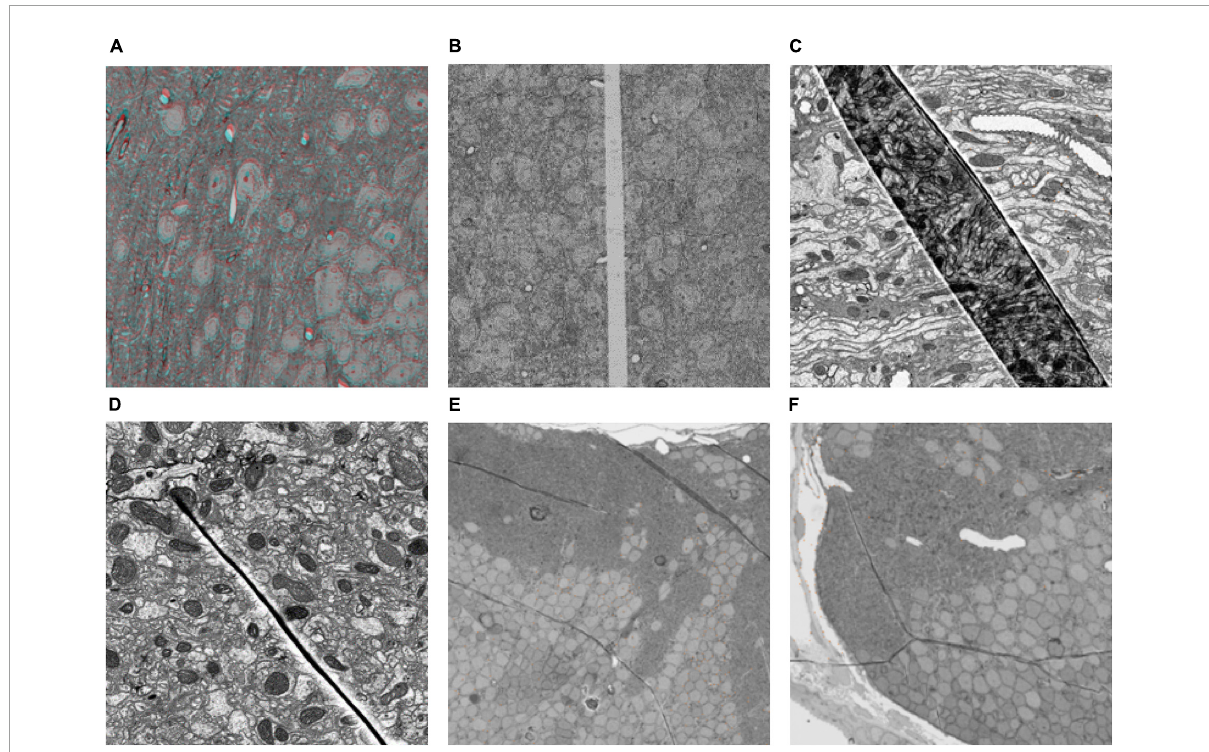
FIGURE1 Some typical section damage images imaged by scanning electron microscope. (A) Continuous deformation. The entire section has been registered to the reference section, but there is still some local deformation. This picture shows the superposition of the red channel of the previous section and the blue and green channels of the next section. The presence of ghosting means that the previous and next sections are not registered perfectly. (B–F) Different types of broken